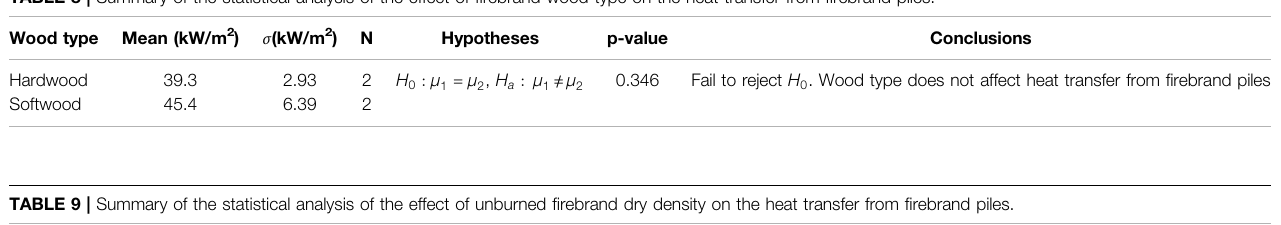
TABLE 9 | Summary of the statistical analysis of the effect of unburned fi rebrand dry density on the heat transfer from fi rebrand piles. Wood dry